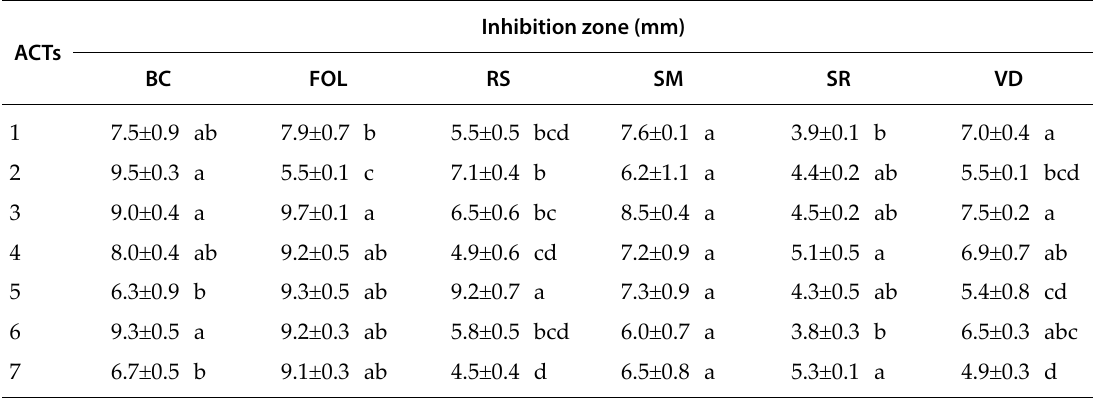
Table 2. In vitro suppression activity of aerated compost teas (ACTs) against Botrytis cinerea (BC), Fusarium oxysporum f. sp. lycopersici (FOL), Rhizoctonia solani (RS), Sclerotinia minor (SM), Sclerotium rolfsii (SR) and Verticillium dahliae (VD), indicated as mean radii of inhibition zones ± 1 SE, measured in well-cut diffusion plate assays. Different letters within a column indicate significant differences ( P ≤0.05) according to Duncan’s